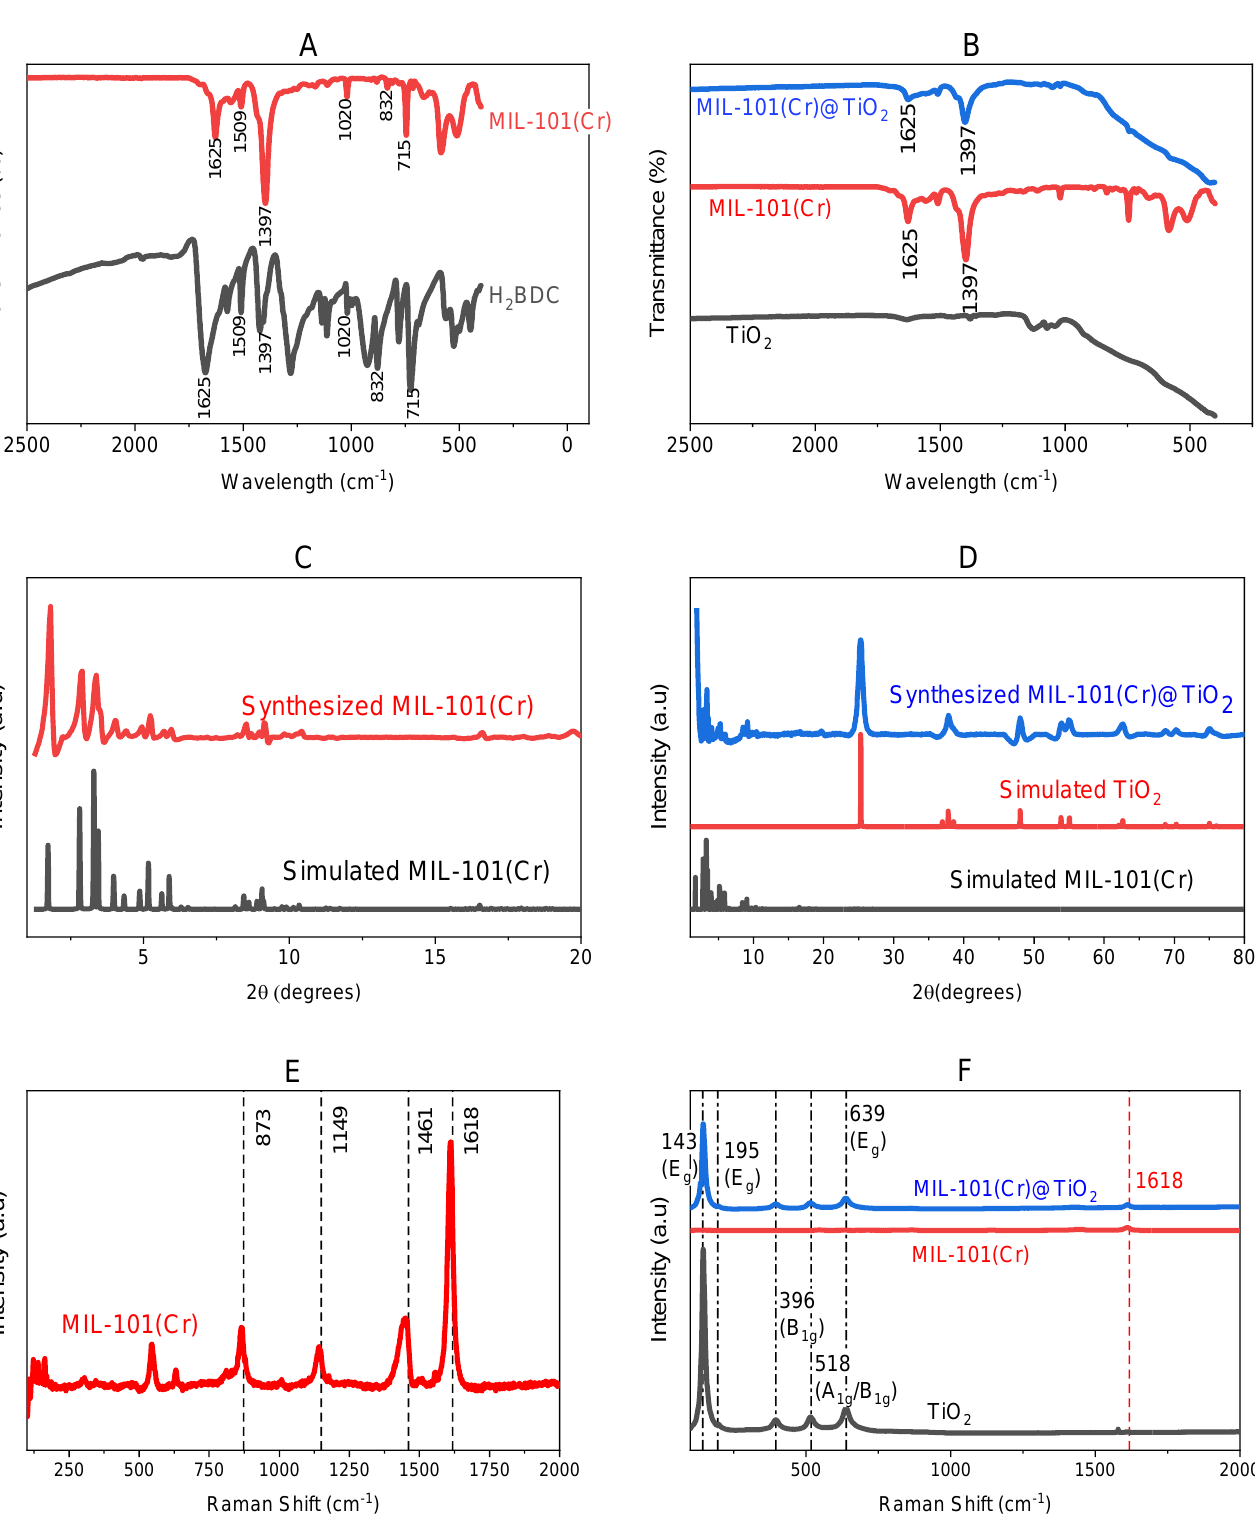
Figure 2. FTIR spectra of ( A ) H 2 BDC and MIL − 101(Cr), and ( B ) MIL − 101(Cr)@TiO 2 , MIL − 101(Cr), and TiO 2; XRD spectra of ( C ) synthesised and simulated MIL − 101(Cr), and ( D ) synthesised MIL − 101(Cr)@TiO 2 and respective simulated constituents; Raman spectroscopy of ( E ) MIL − 101(Cr), and ( F ) MIL − 101(Cr)@TiO 2 and TiO 2 .